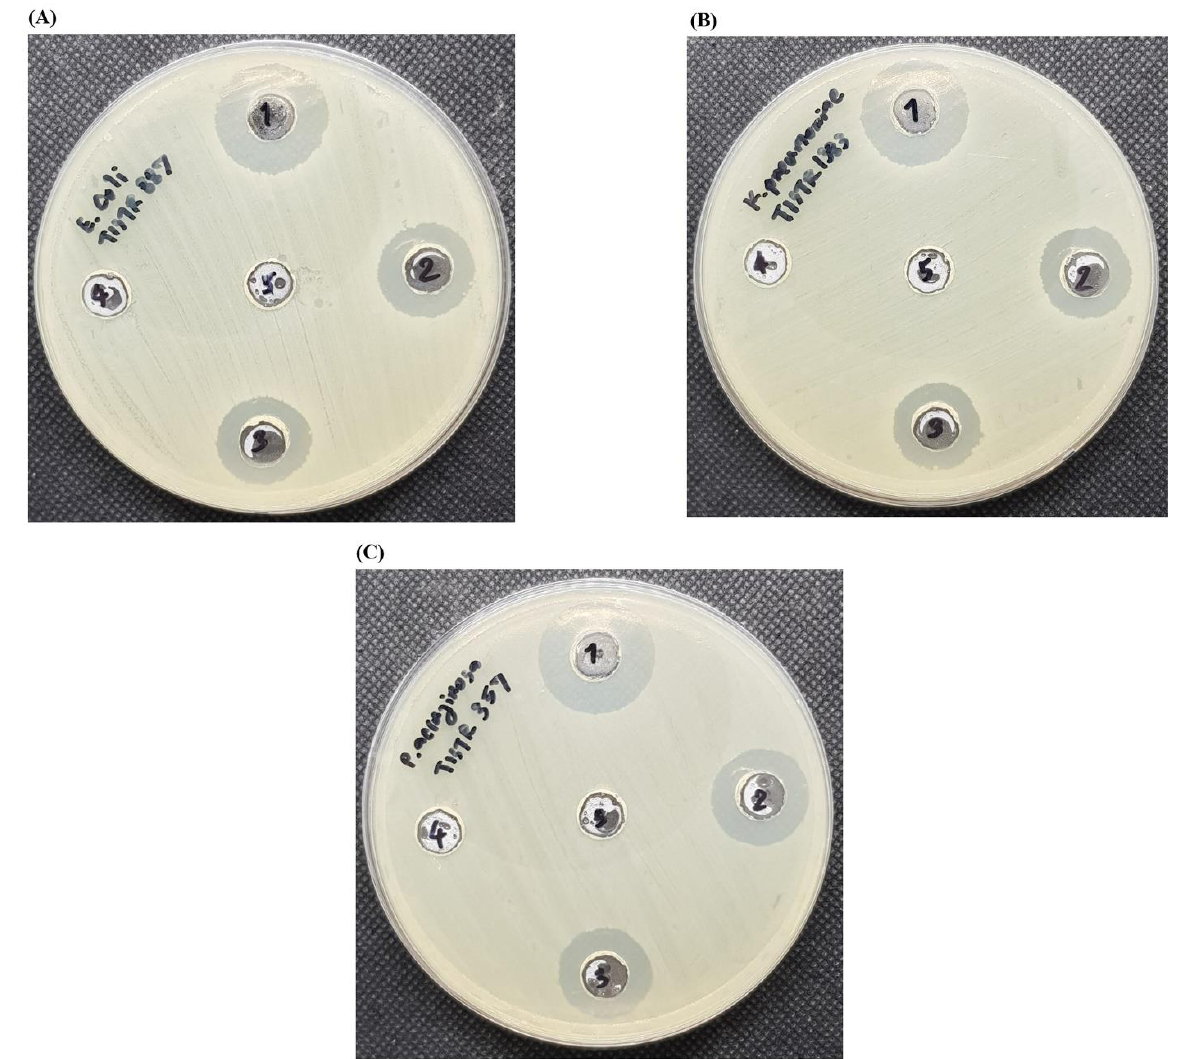
Figure 6. Agar well diffusion assay for nanoparticles. The indicator bacteria were ( A ) E . coli TISTR 887, ( B ) K . pneumonia TISTR 1383, and ( C ) P . aeruginosa TISTR 357. The numbers 1 to 5 represented F3, F3 physical mix, colistin, F0, and DI water, respectively .